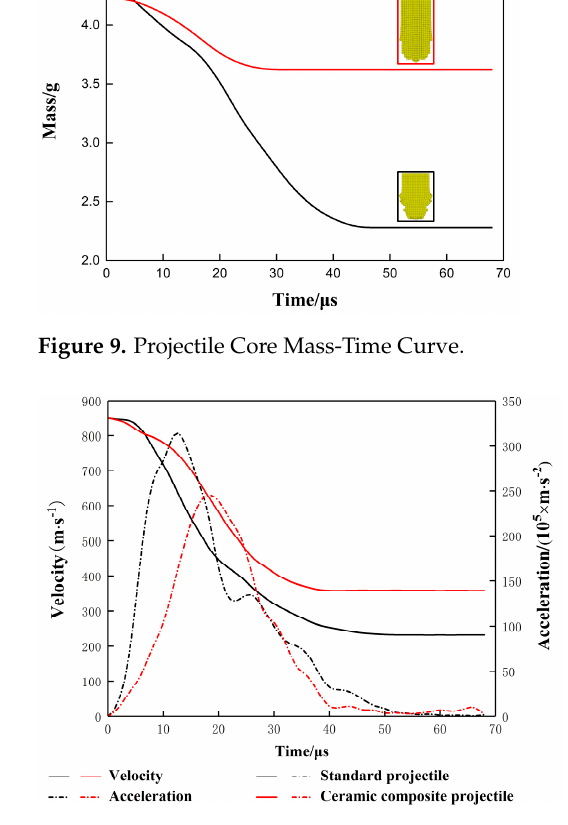
Table 3. Test and simulation data of projectiles with different structures penetrating a 10 mm RHA. Projectile Structure